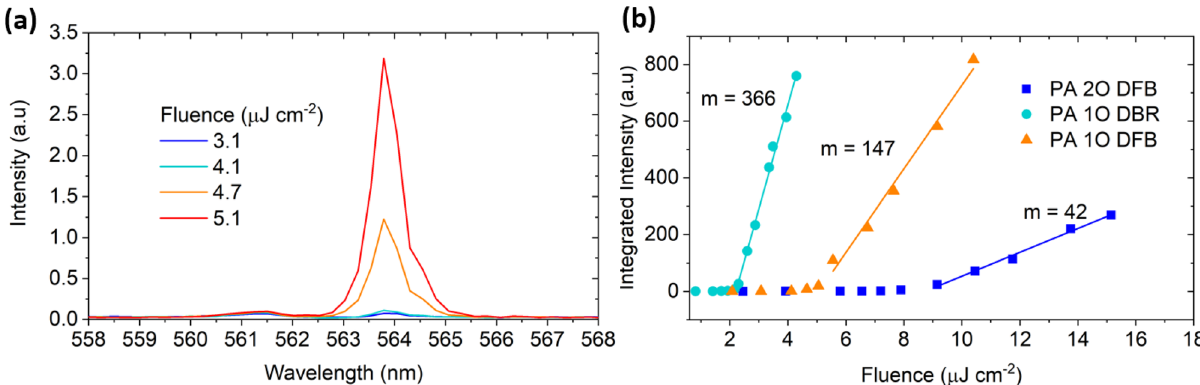
Figure 3. ( a ) Fluence dependant spectra for 60% γ PA 1O DFB, ( b ) typical fluence dependant output of integrated spectral output near the lasing wavelength for 60% γ PA 1O DBR/ DFB and 2O DFB lasers, with slope efficiency, m